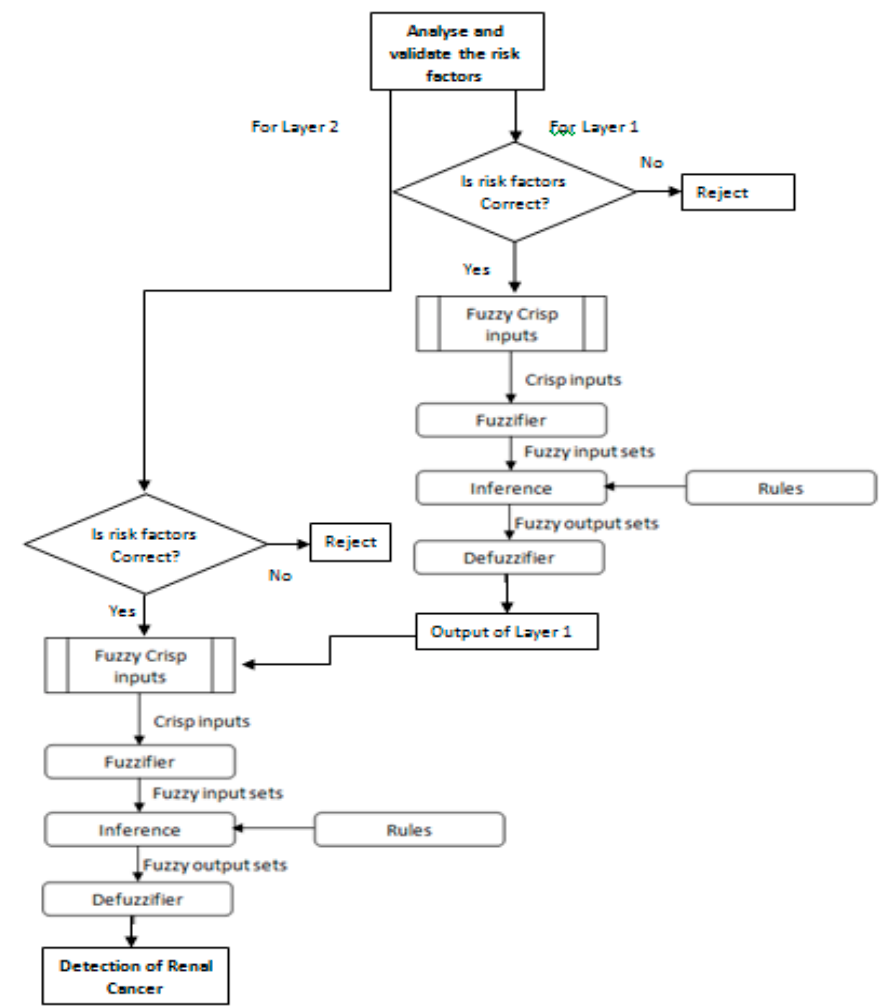
Figure 4. Methodology of the proposed multi-layered inference system.